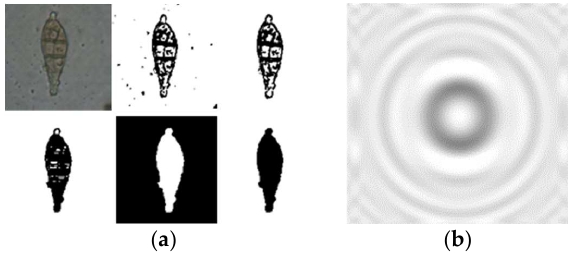
Figure 8. Spore image processing and spore fingerprint captured in this work. ( a ) Gray processing of spore image; ( b ) spore diffraction fingerprint calculation.